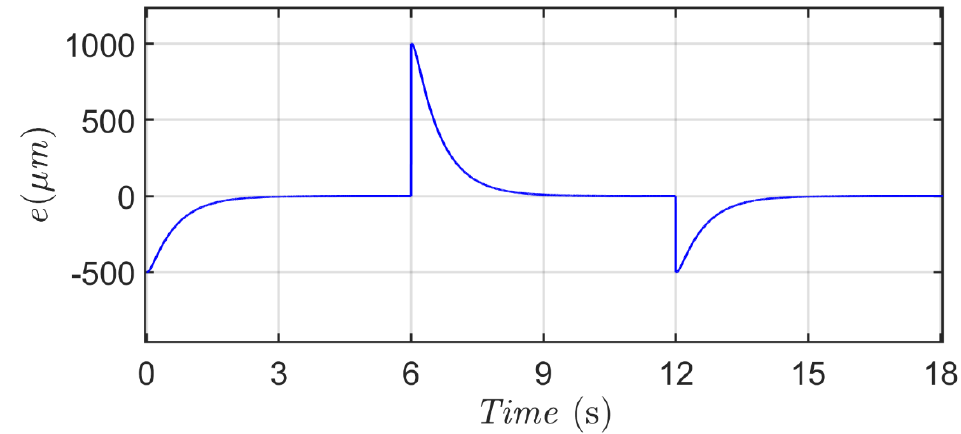
Figure 16. Micro-positioning error for a desired stair-type trajectory.